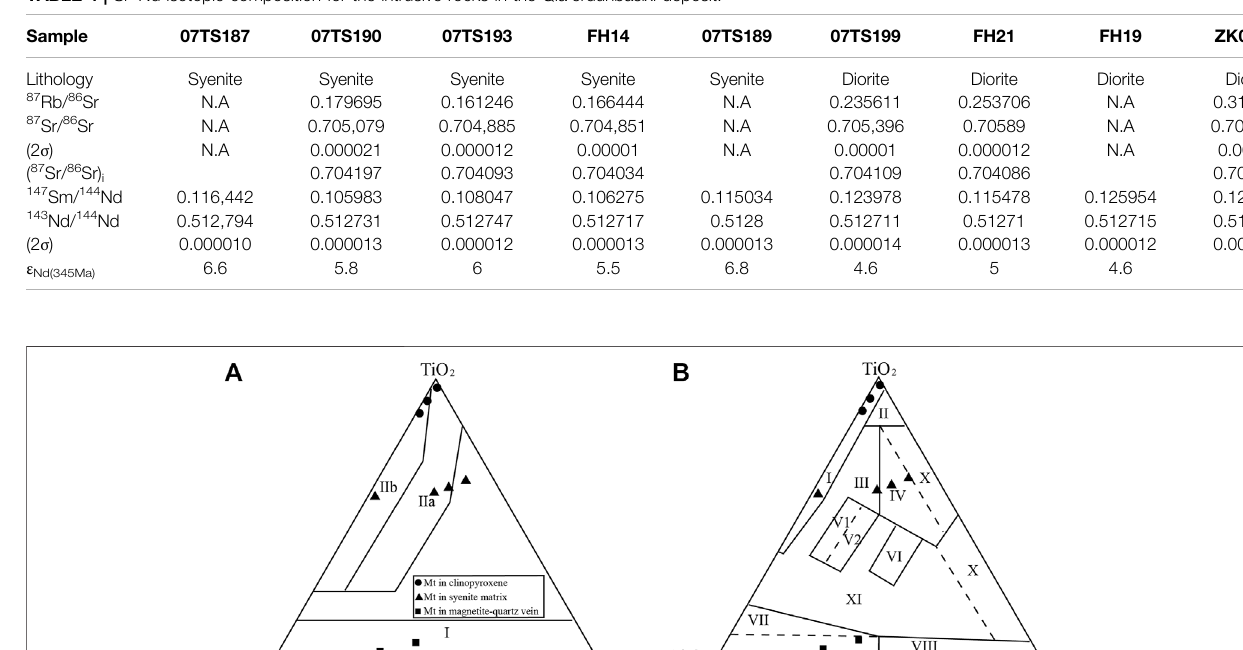
TABLE 4 | Sr – Nd isotopic composition for the intrusive rocks in the Qia ’ erdunbasixi deposit.